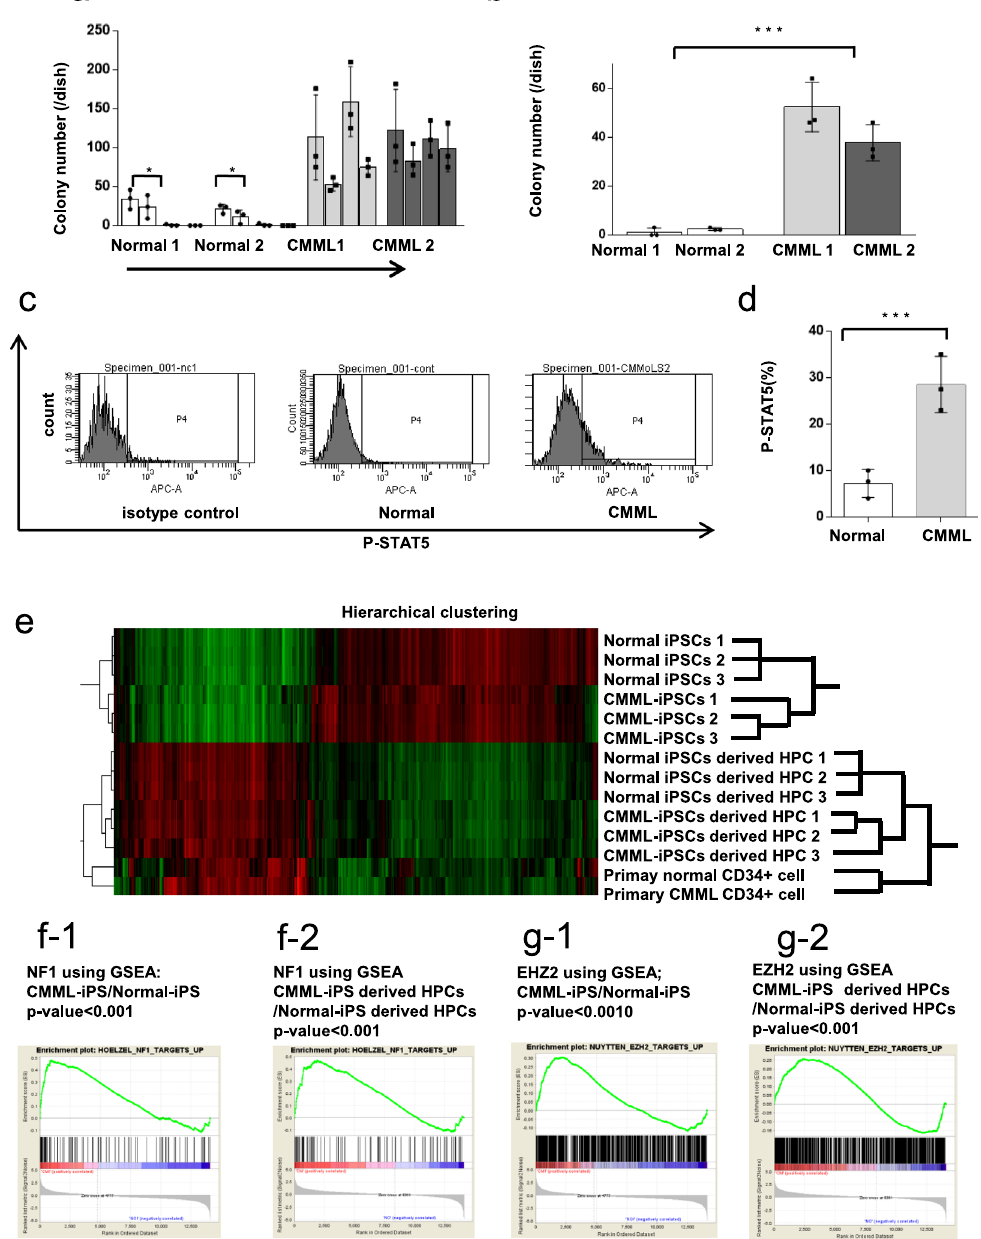
Figure 3. Characteristics of colony formation and genetic analysis of CMML iPSC-derived HPCs. ( a ) CMML iPSC-derived HPCs retained their serial re-plating capacity and generated colonies even after the fourth plating, whereas Normal iPSC-derived HPCs lost the ability to generate colonies after the second plating. CMML iPSC- derived HPCs showed an enhanced self-renewal capacity ( n = 3, independent experiments, * p < 0.05, Normal- iPSCs1 and 2 from a healthy donor, and CMML-iPSCs1 and 2 from a CMML patient, Statistical analyses were performed with ANOVA and the Dunnett post-test for multiple comparisons. * p < 0.05). ( b ) The CMML iPSC- derived HPCs generated hematopoietic colonies under cytokine-deprived conditions. The CMML iPSC-derived HPCs could form hematopoietic colonies, while Normal iPSC-derived cells gave rise to few detectable colonies ( n = 3, independent experiments, *** p < 0.001, Normal-iPSCs1 and 2 from a healthy donor, and CMML-iPSCs1 and 2 from a CMML patient, paired two-sided t -test). ( c ) Using pStat5 intracellular flow cytometric analysis, we observed increased phosphorylation of STAT5 in CMML iPSC-derived CD34 + CD43 + HPCs. ( g – i ) The profiles of the surface antigens in the colonies from CMML iPSC-derived HPCs and controls were analyzed using FACS. ( d ) The percentage of pSTAT5 on CMML iPSC-derived CD34 + CD43 + HPCs was significantly higher than Normal- iPSC-derived HPCs ( n = 3, independent experiments, *** p < 0.001, Normal-iPSCs1 from a healthy donor, and CMML-iPSCs1 from a CMML patient, paired two-sided t -test). ( e ) Hierarchical clustering analysis of gene expression patterns. Using hierarchical clustering, these cells were distinguished into two groups: the Normal/CMML iPSC group and Normal/CMML iPSC-derived HPC group. (f-1 and f-2) Expression data